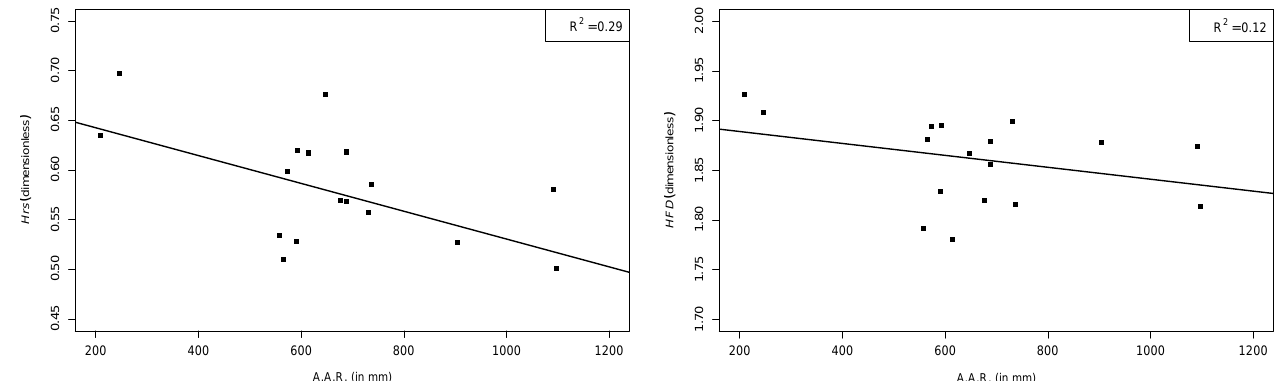
Figure 5. Relation between fractal exponents and A.A.R., showing their coefficients of determination (R 2 ) of the